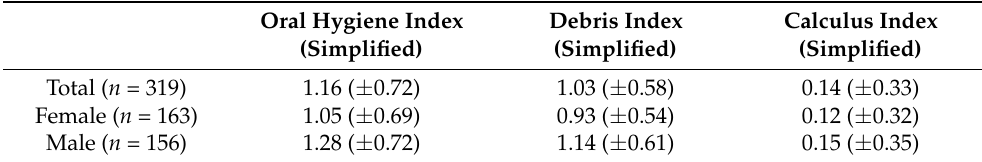
Table 2. Mean values of the Simplified Oral Hygiene Index (OHI-S) parameters.